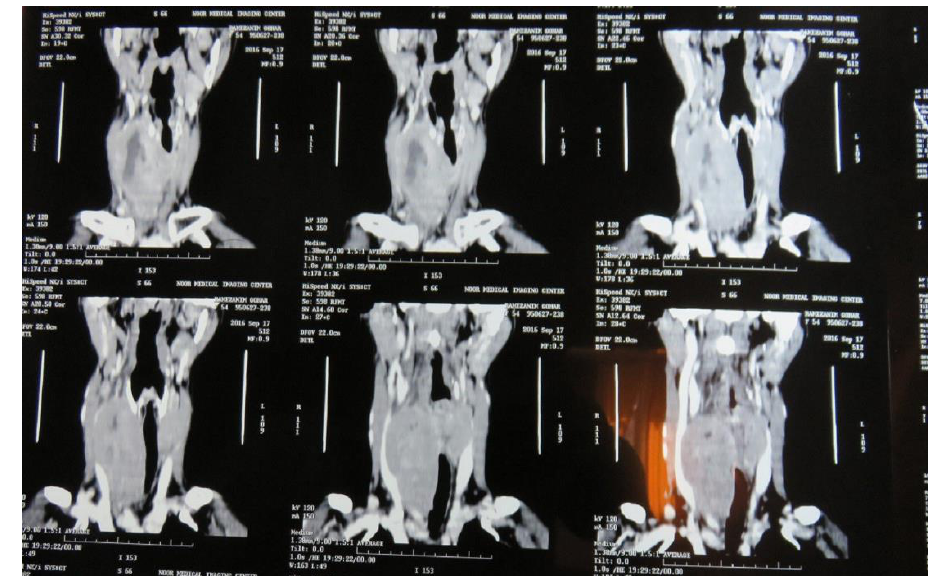
Figure 2. CT scan is shown with a preoperative diagnosis of anaplastic thyroid